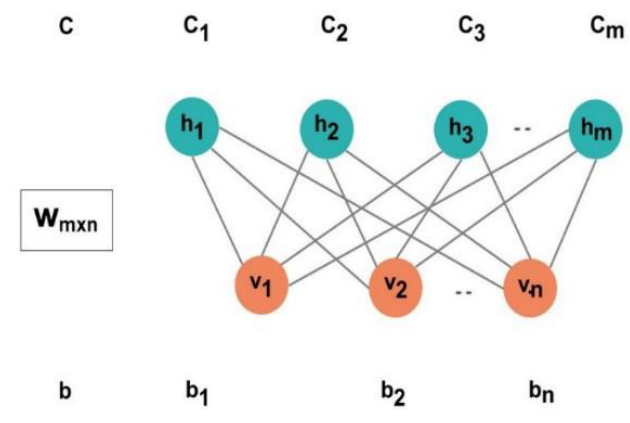
Figure 3. Schematic of a restricted Boltzmann machine. Source: Sezer et al. [14].